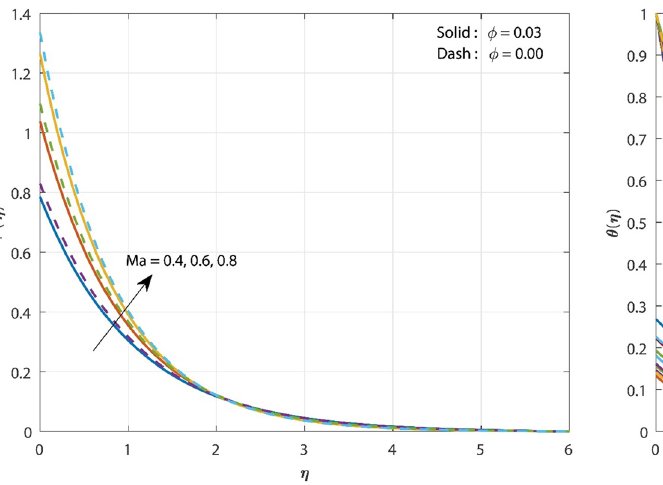
Figure 3: Plot of f ′ ( η ) over di ff erent values of Ma.